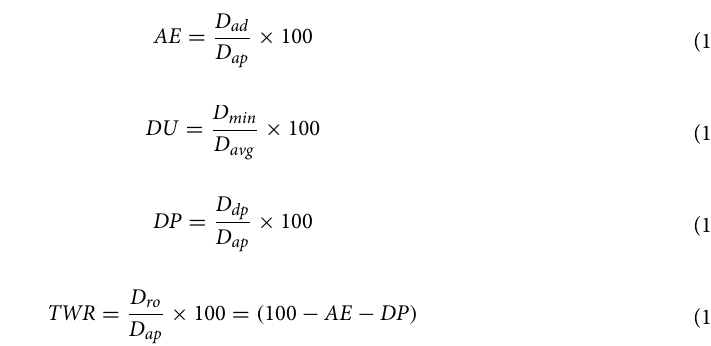
and k of the first surge and final f 0 were used. The values of the calibrated parameters in WinSRFR were deter- mined by trial and error to find the best match between the measured and simulated advance-recession times and infiltrated water depth (Table 4).